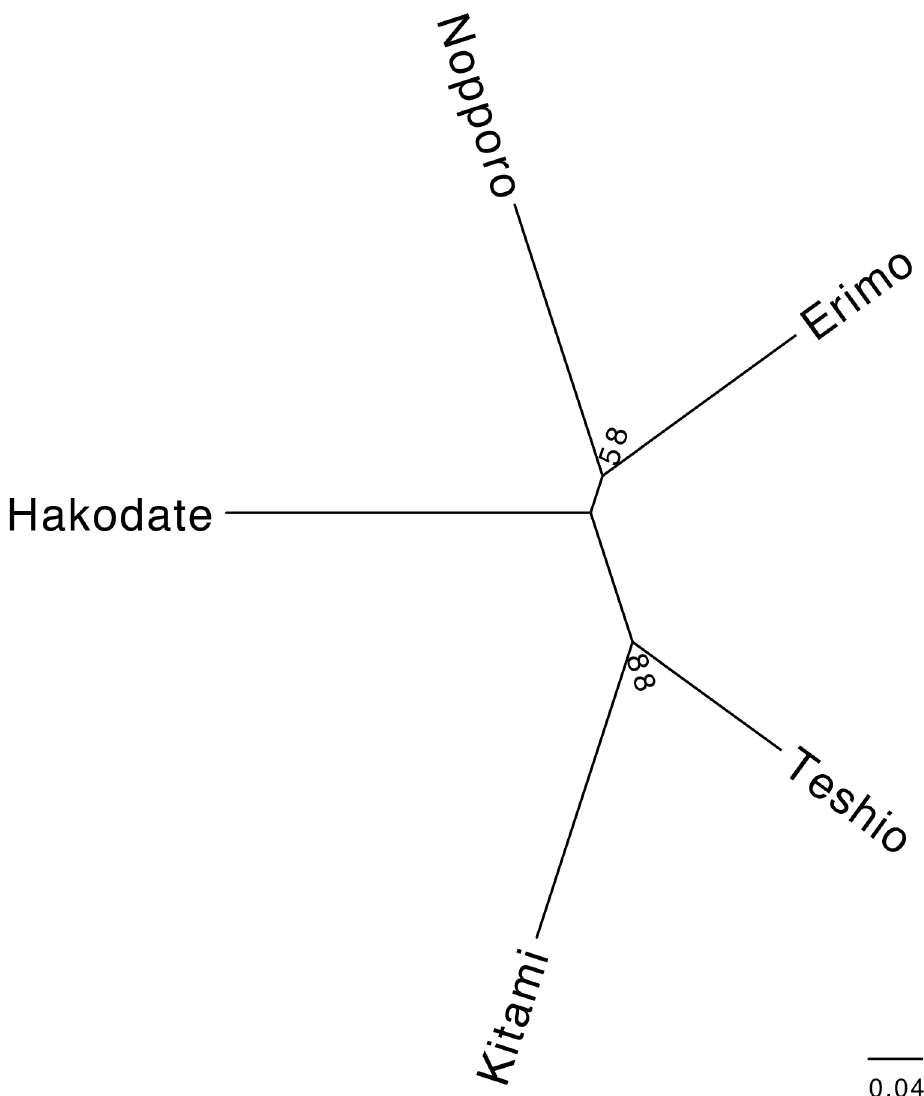
Fig 2. Phylogenetic relationships among five local populations of Hokkaido salamanders. This neighbor-joining phylogenetic tree was reconstructed by using Nei ’ s D A distances. The number at each node indicates the bootstrap probability (%) with 1000